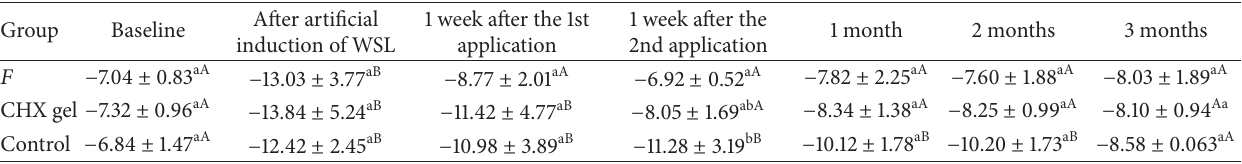
Table 2: Mean and SD of the fluorescence values for each group during the experimental time.